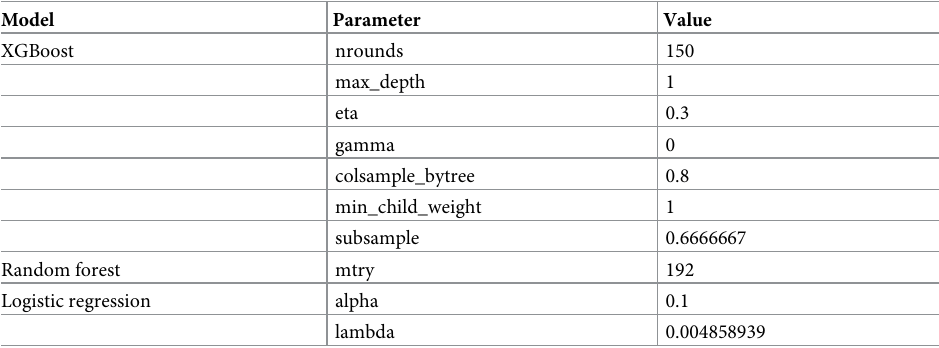
Table 1. Parameter values in each